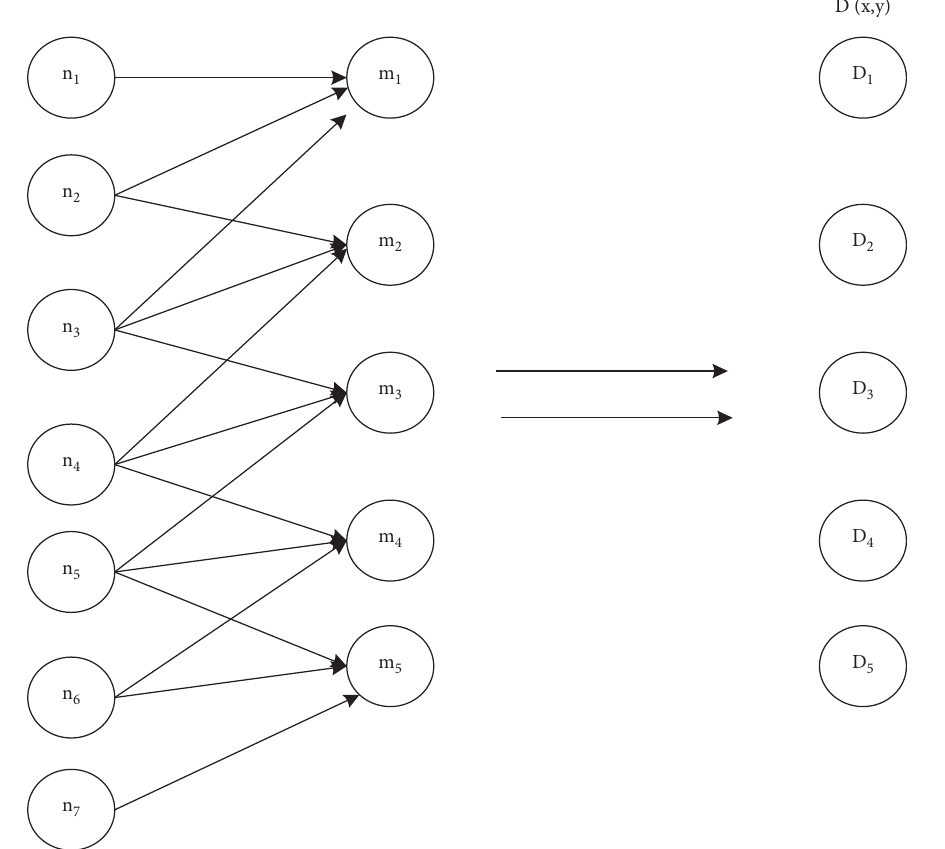
Figure 4: Cumulative distance update